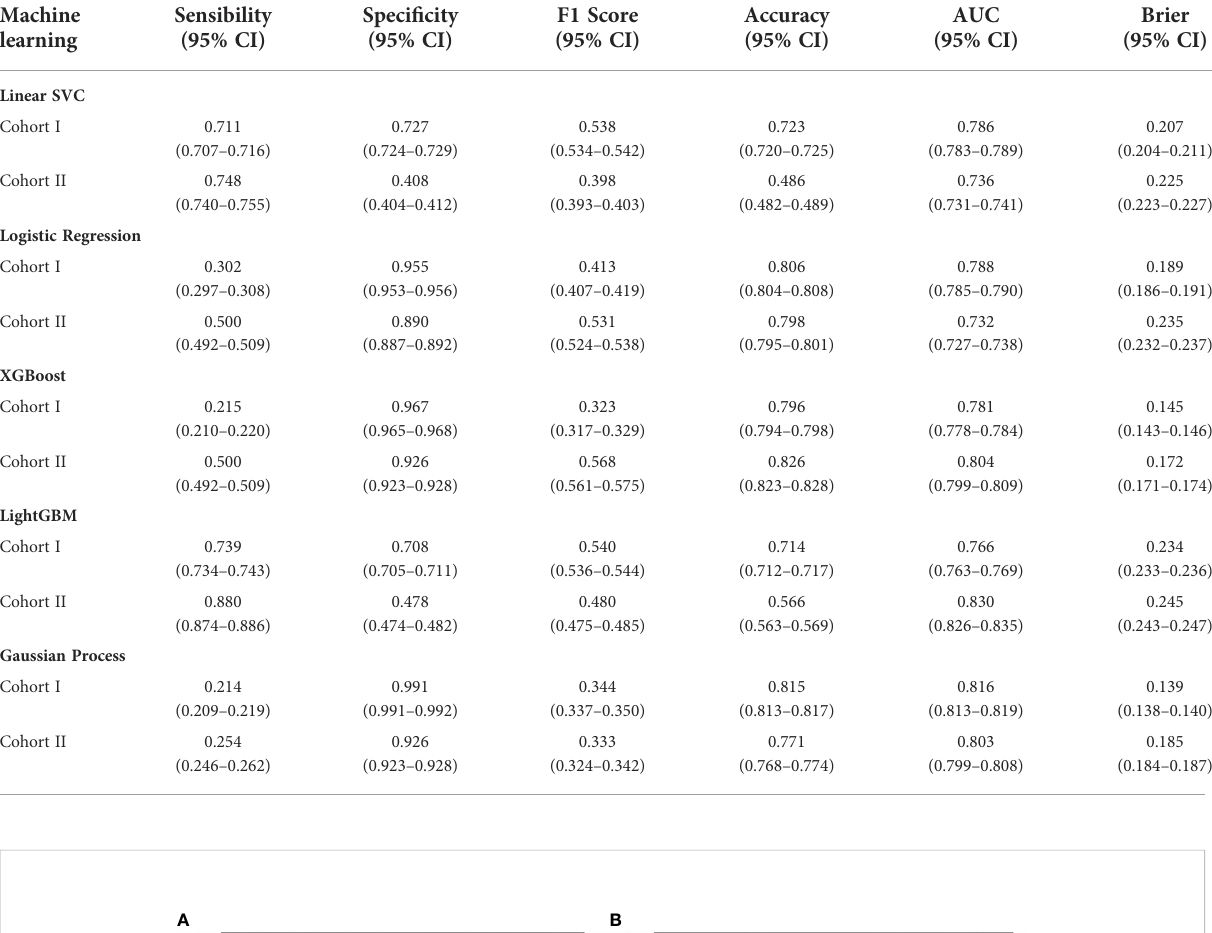
TABLE 3 Validation performance for the prediction of LNM of EGC by using fi ve machine learning classi fi ers. Machine learning